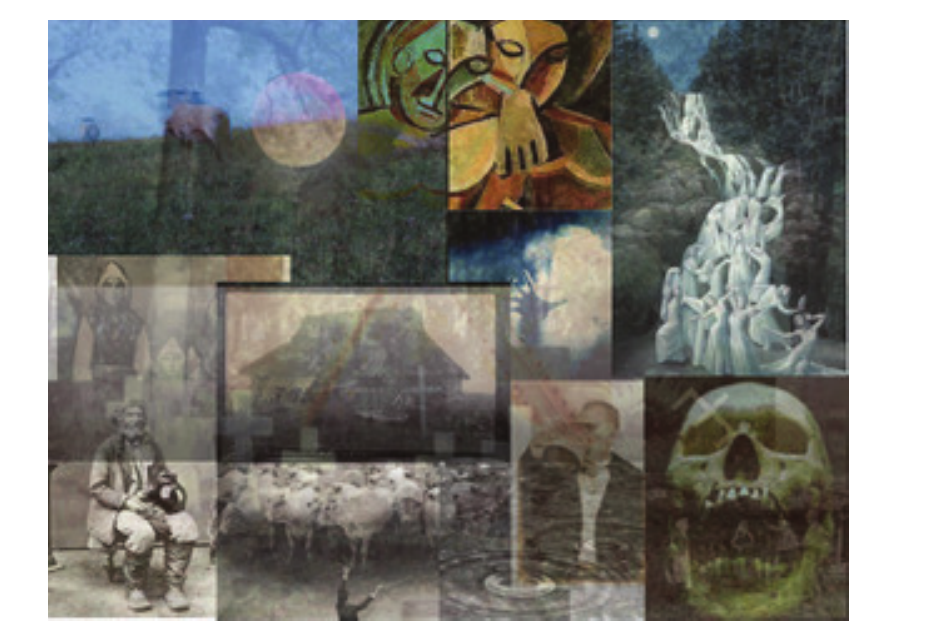
Figure 1: A mood board created by a student